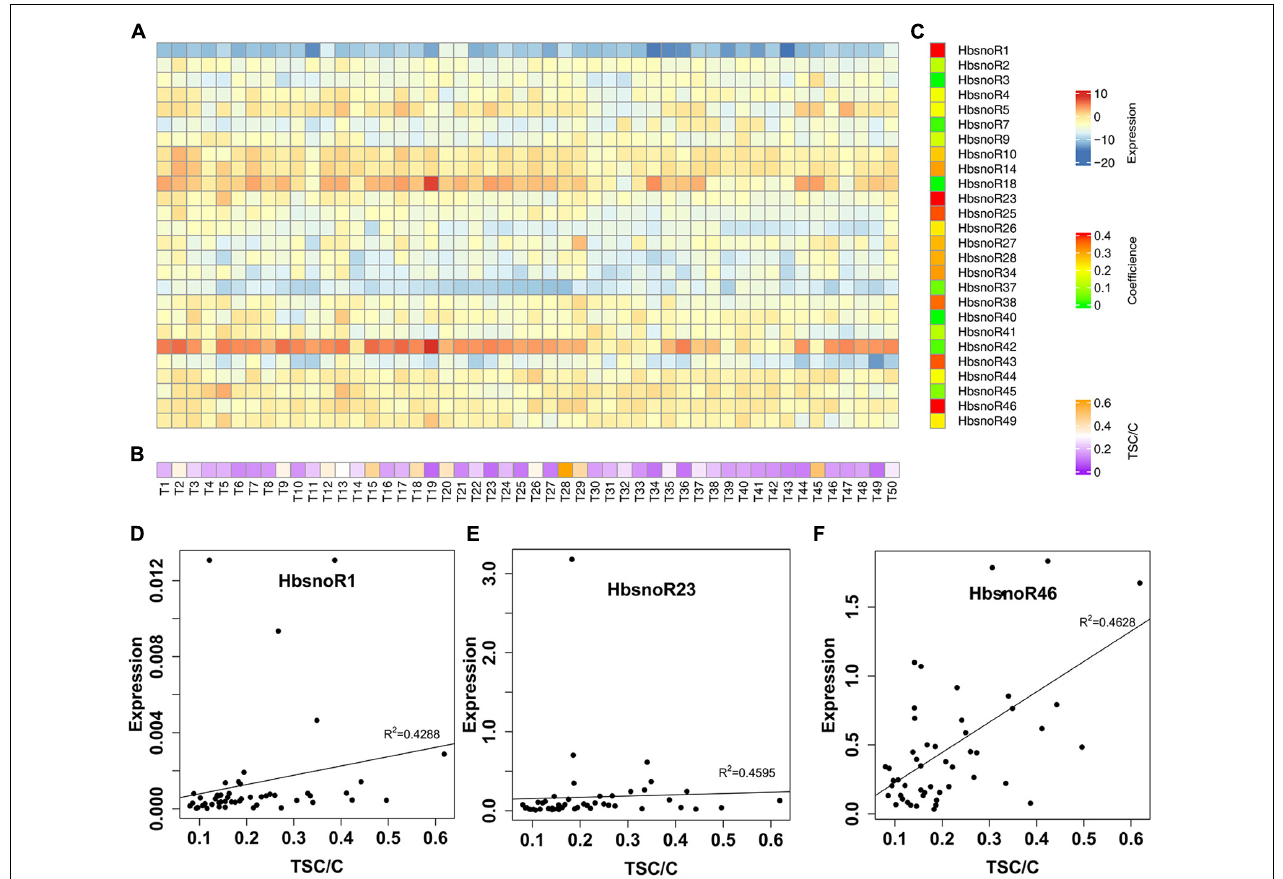
FIGURE 5 | Identification of snoRNAs positively correlated with latex yield in rubber trees. (A) Heatmap showing the qPCR expression of 26 validated snoRNAs in a Reyan66-2 × PR107 population with 50 F1 individual trees. (B) Heat map of the adjusted total solid content (TSC) (TSC/C) of F1 offspring. (C) Heat map of the Spearman correlation coefficient for each snoRNA between expression and TSC/C in F1 offspring. A high correlation coefficient was shown in red. (D–F) Plots showing the correlation coefficient of HbsnoR1 , HbsnoR23 , and HbsnoR46 , respectively. At least three biological replicates were used for these